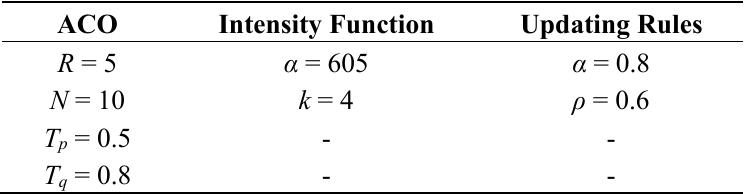
Table 1. The values of parameters for the proposed ACO